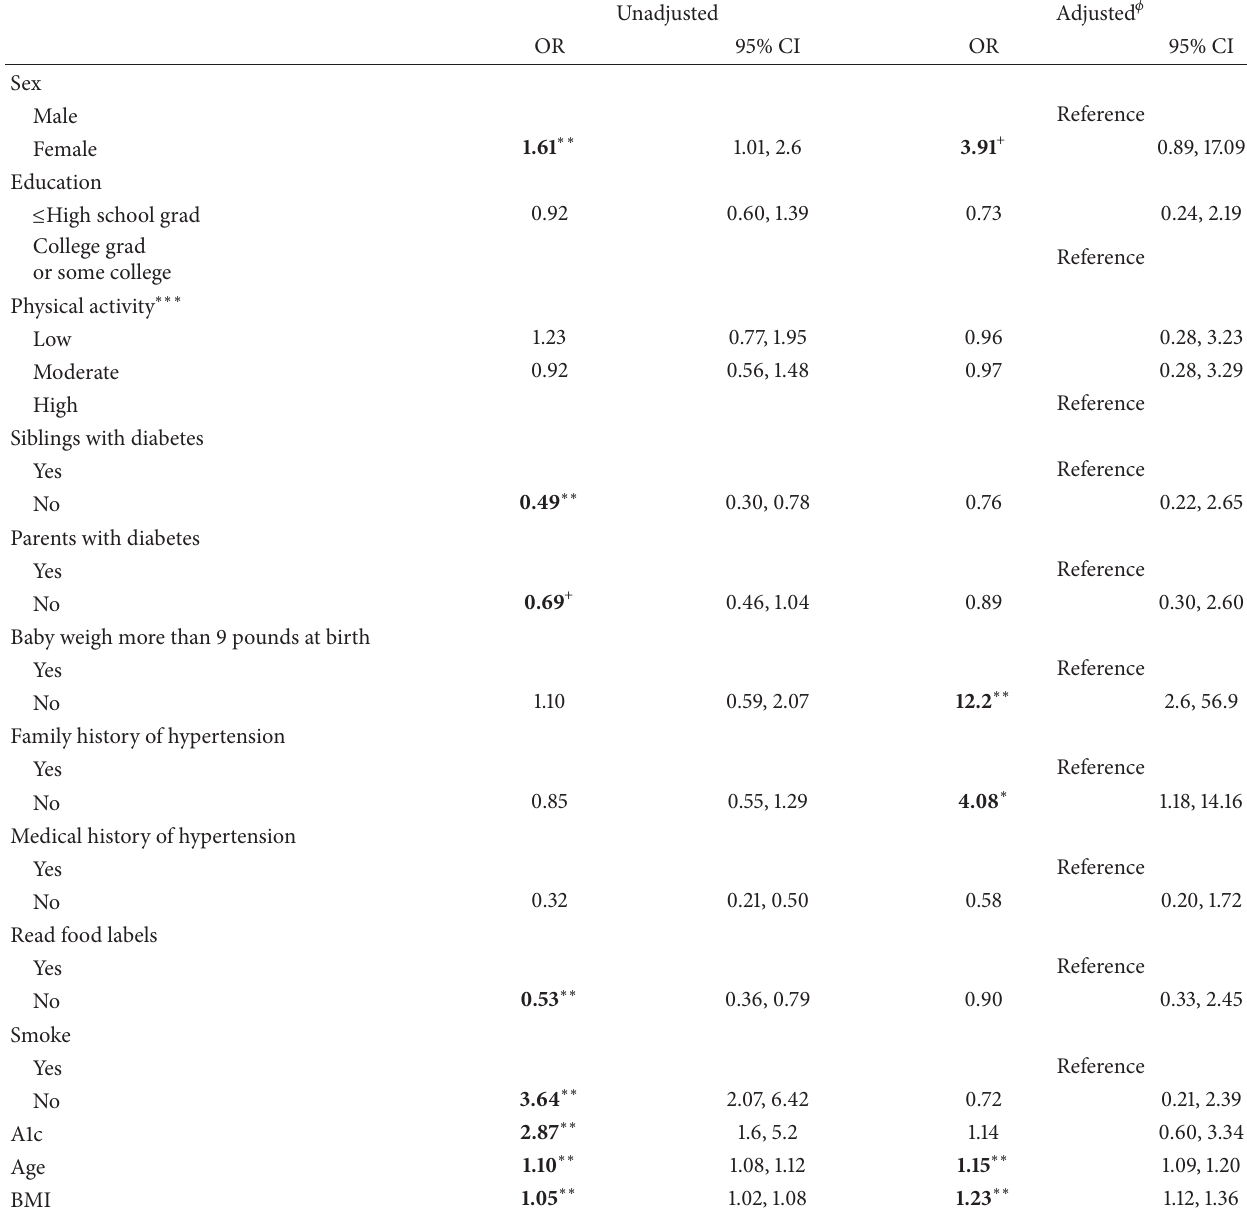
Table 3: Logistic regression: predicting high risk for prediabetes 󳶚